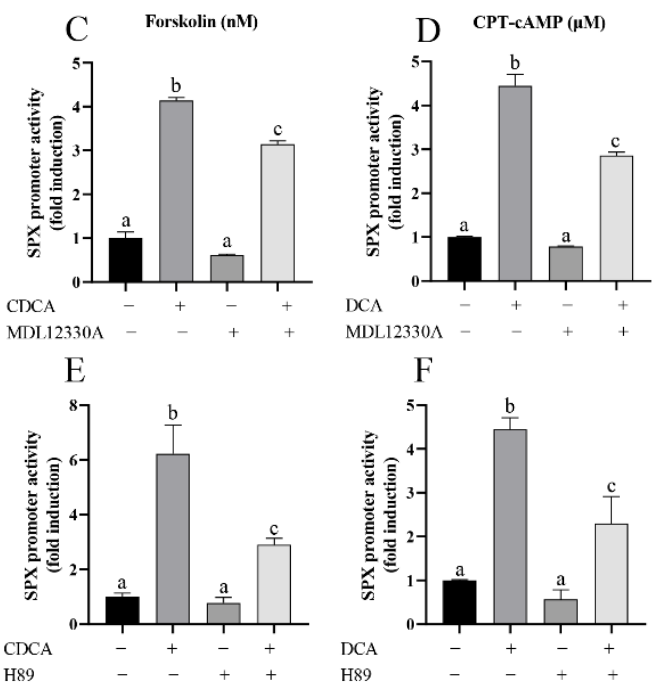
Figure 4. The role of AC/cAMP/PKA pathway in bile acid-promoted SPX promoter activity. ( A ) Dose-dependent (10–1000 nM) effects of forskolin on SPX promoter. ( B ) Dose-dependent (10–100 µ M) effects of Cpt-camp on SPX promoter. ( C ) SPX promotor activity was measured with CDCA treatment in the presence or absence of MDL12330A. ( D ) SPX promotor activity was measured with DCA treatment in the presence or absence of MDL12330A. ( E ) SPX promotor activity was measured with CDCA treatment in the presence or absence of H89. ( F ) SPX promotor activity was measured with DCA treatment in the presence or absence of H89. The groups denoted by different letters represent a significant difference at p <